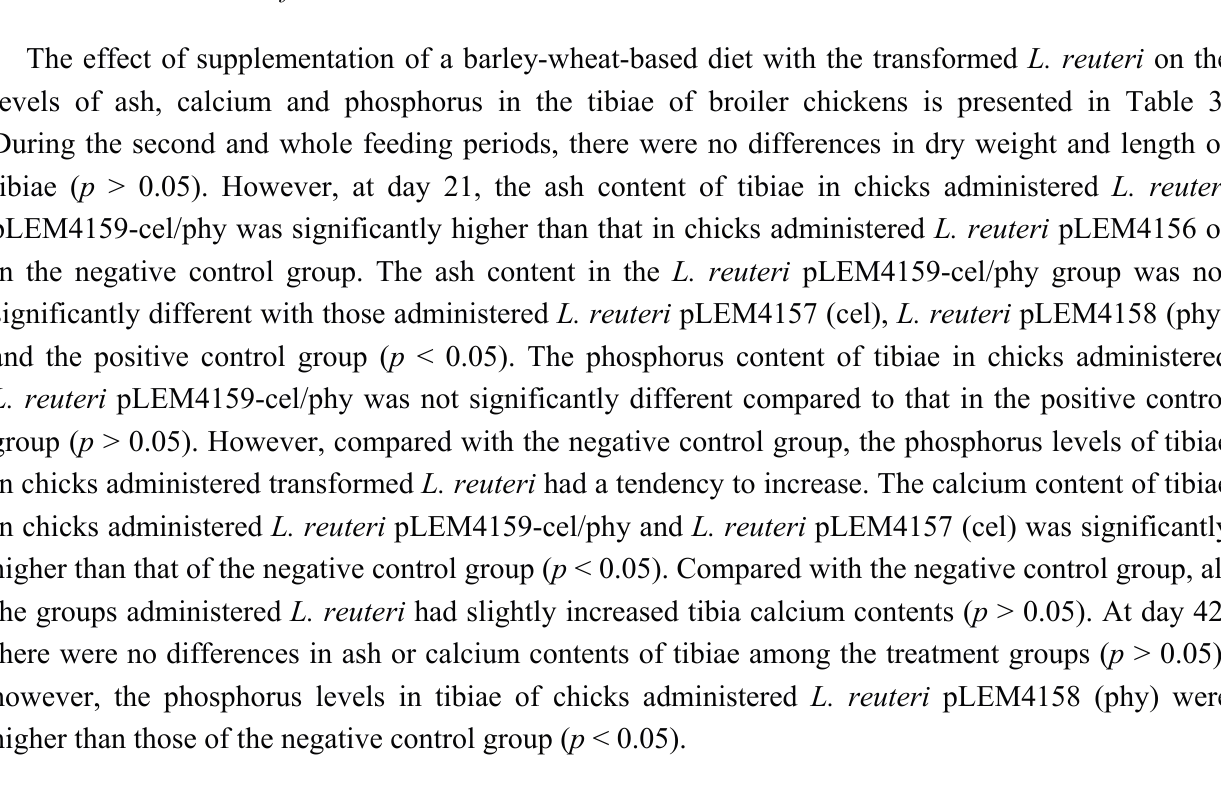
Table 3. Effects of transformed L. reuteri strain supplementation on tibia